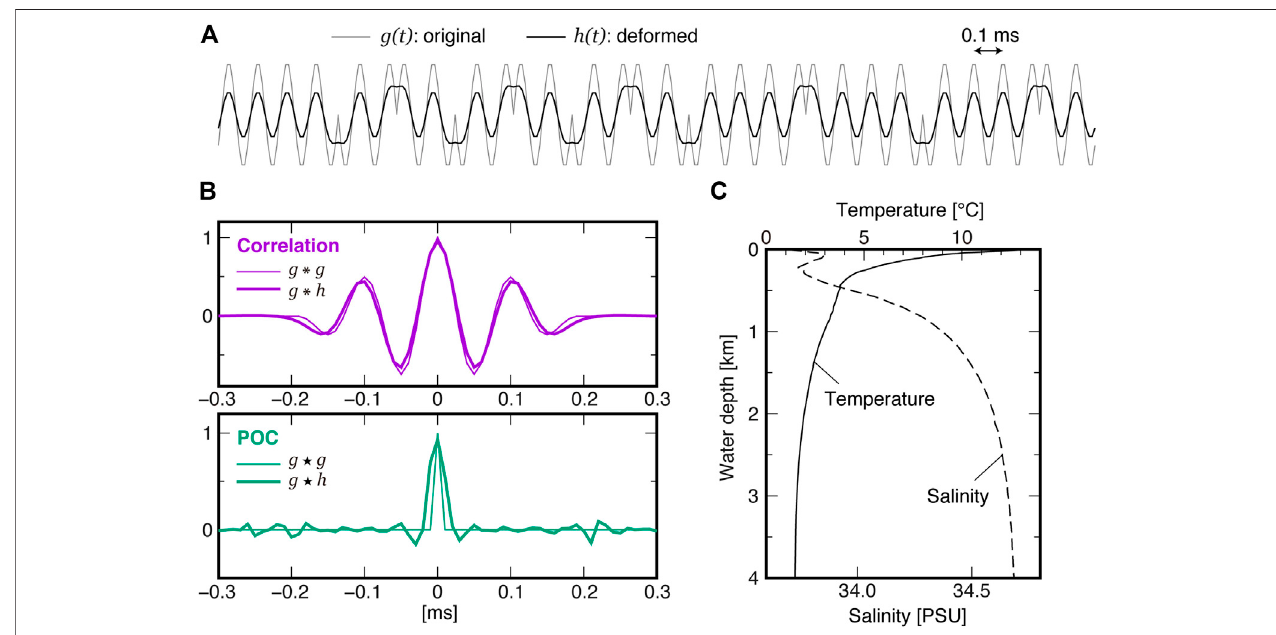
FIGURE 10 | Effect of the frequency-dependent signal attenuation by absorption in seawater. (A) A part of the deformed reference signal through a round trip to a depth of 4 km along a vertical path. (B) The cross-correlation (top) and POC (bottom) between the original and deformed signals (bold lines). The auto-correlation of the reference signal is shown by thin lines. (C) Depth-pro fi le of temperature and salinity used for the calculation of the signal attenuation by absorption.